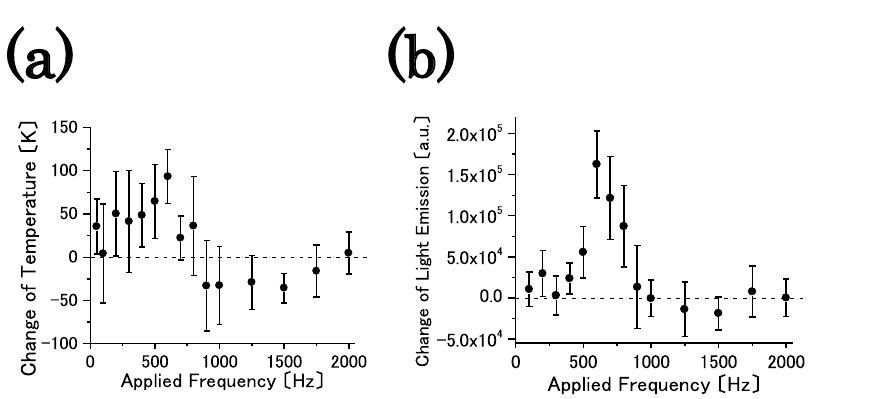
Figure 4. ( a ) Change in flame temperature and ( b ) change in flame light emission for frequency of applied ac voltage as rectangular voltage pulse are shown. Amplitude of applied electric field is fixed at 5152